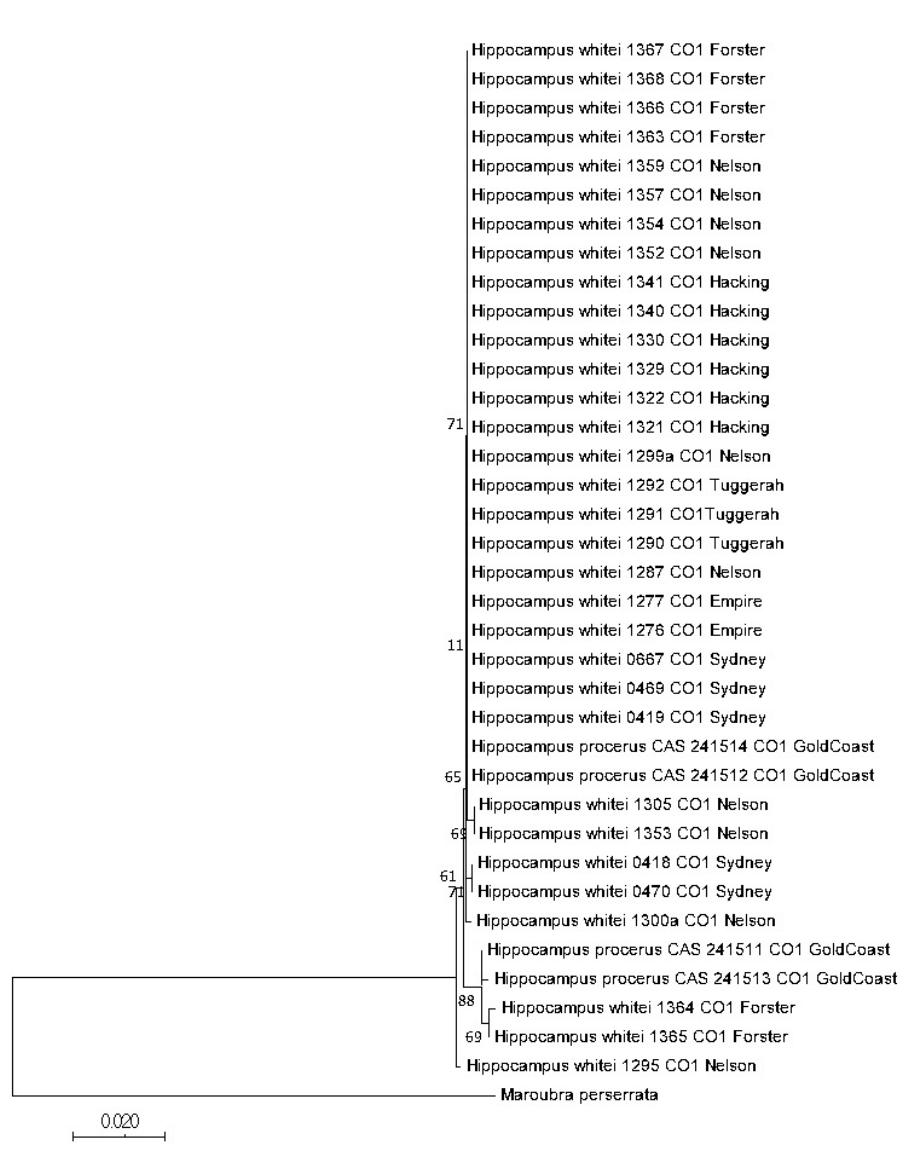
Figure 13. Neighbor-joining tree based on mtDNA COI sequences showing the relationships among specimens of H. whitei collected from various sites in NSW and H. procerus from Southport, Gold Coast Harbour, QLD. Numbers in branches indicate bootstrap probabilities obtained from 1000 bootstrap replications. Scale bar = genetic distance of